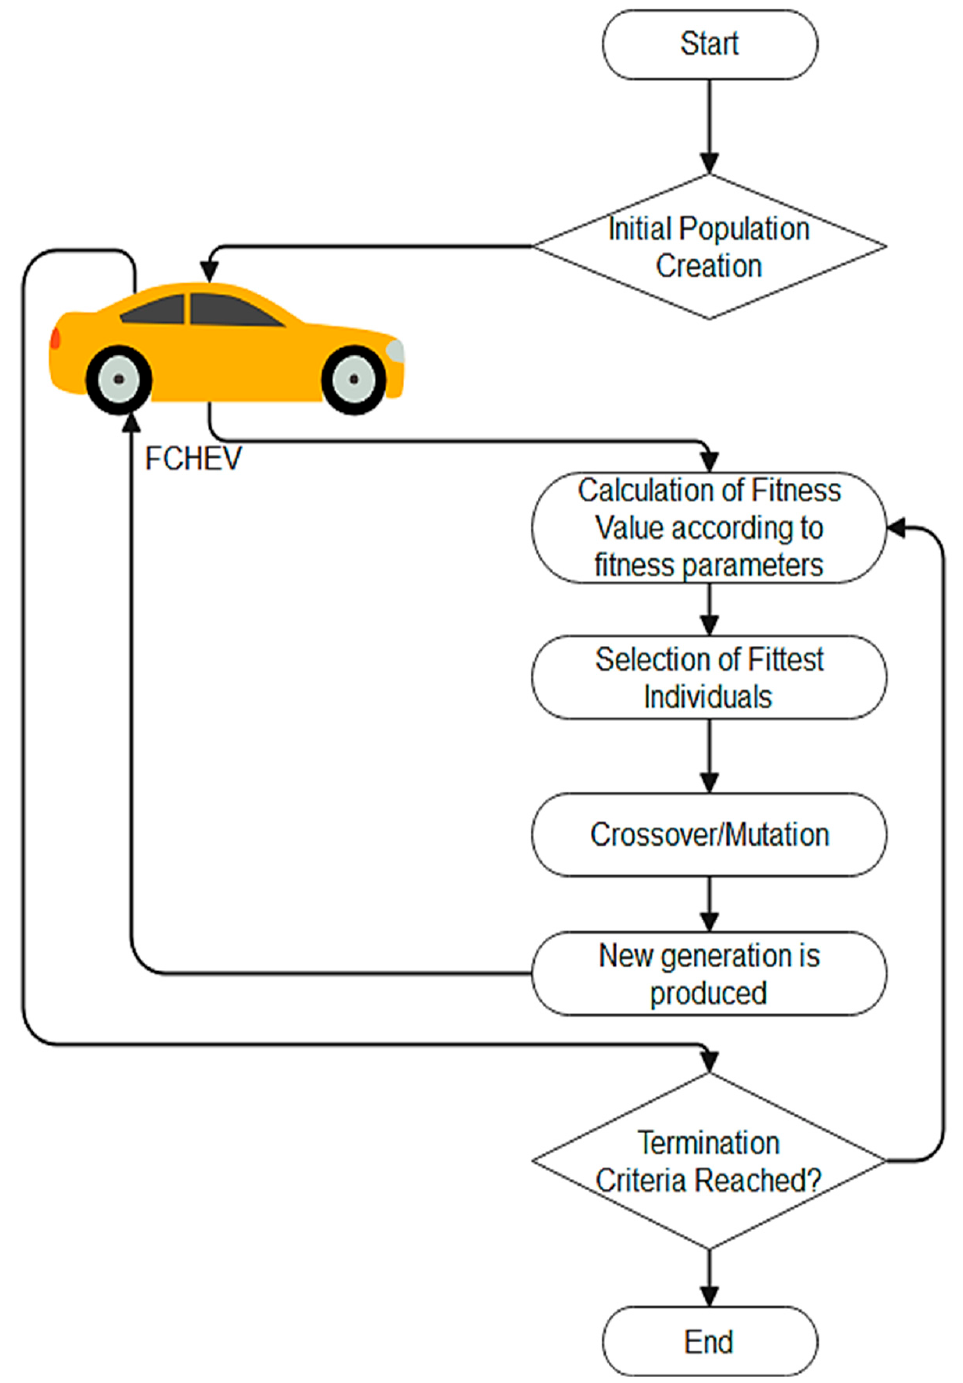
Figure 9. GA with FCHEV fl owchart.